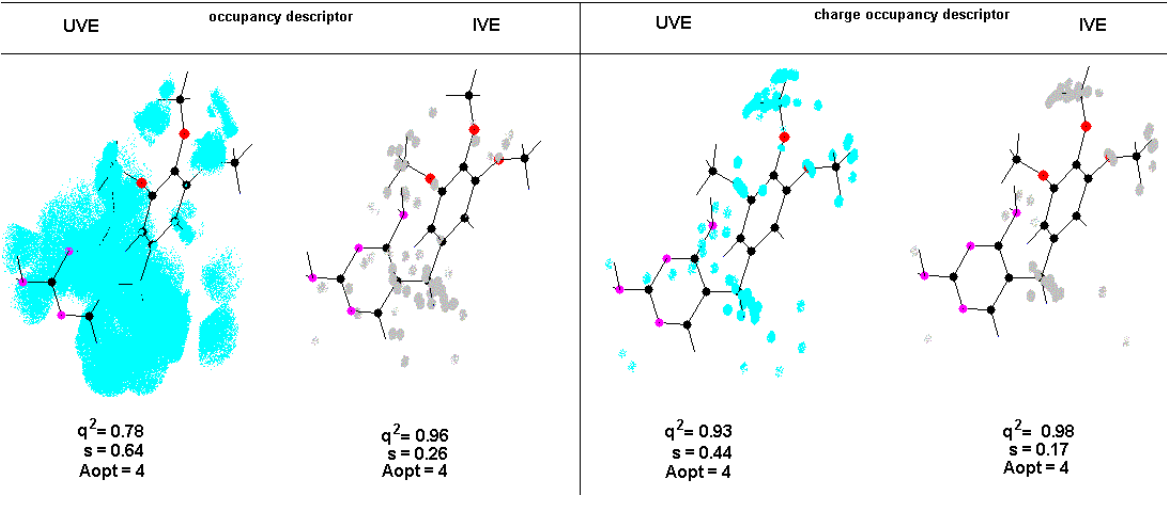
Figure 2. The SOM-4D QSAR models of the DRI series, performed using the occupancy and charge type IPEs. The numbers indicate the q 2 and s performances, and optimal number of the PLS latent variables included in the model; after UVE and IVE data elimination, respectively